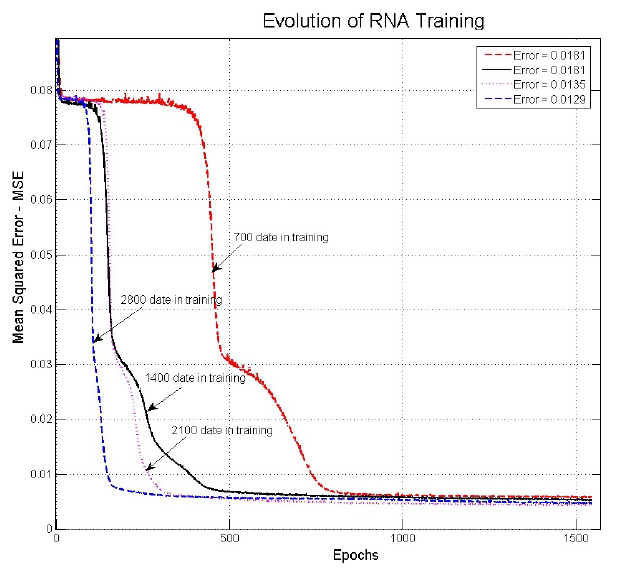
Figure 7. Typical learning curves of the MLP (2, 25, 20, 3) network for different sizes of the training